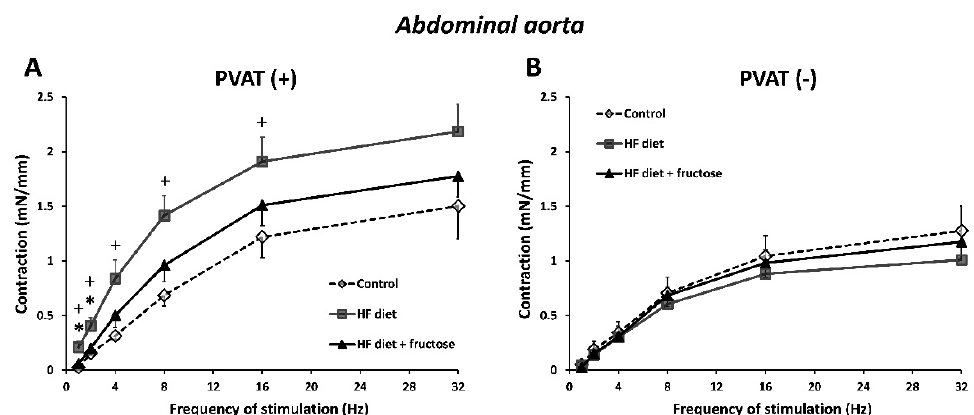
Figure 2. Frequency-dependent contractile responses to transmural electrical stimulation in PVAT(+) ( A ) and PVAT( − ) ( B ) preparations of mesenteric artery from Wistar–Kyoto rats: control, treated with high-fat (HF) diet, and treated with HF